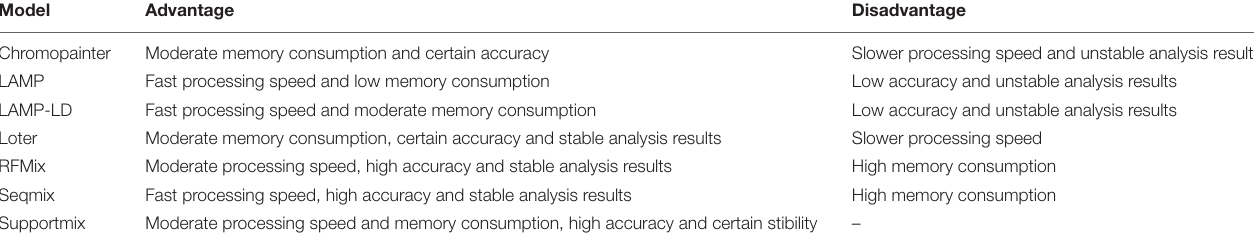
TABLE 4 | Weighing of most used LAI models.